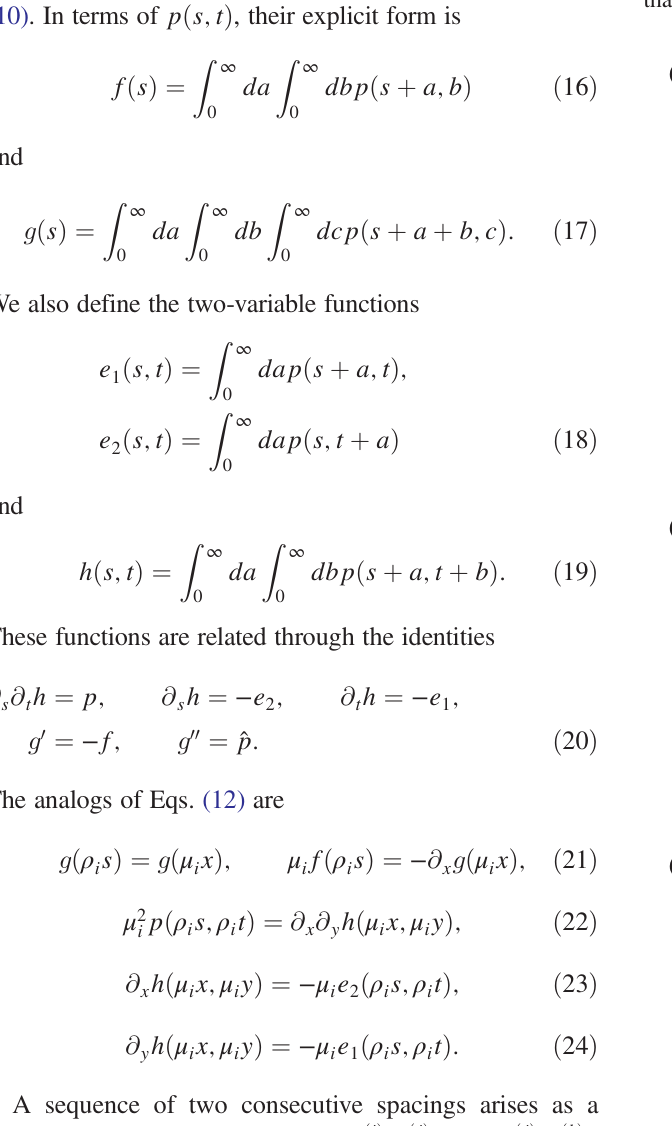
FIG. 1. Four configurations of consecutive spacings considered in Sec. III B. Different colors correspond to distinct spectra. The three central levels are the ones from which the ratios are calculated; the outer levels are at the same height to indicate that their relative position is